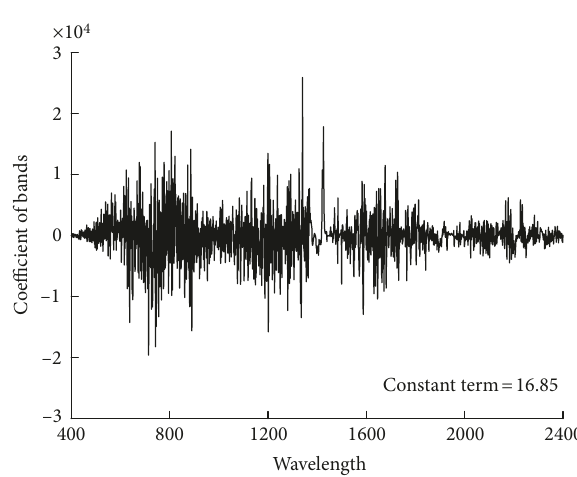
Figure 4: The coe ffi cients of all bands and the constant